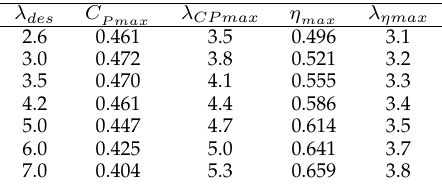
Fig. 15. Model turbine: convergence history of C values from 2.6 to 7.0.